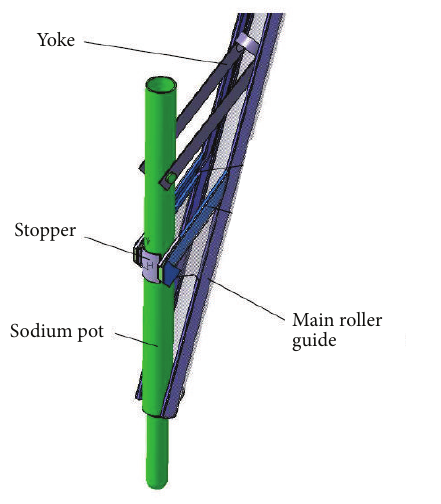
Figure 12: View of the ramp